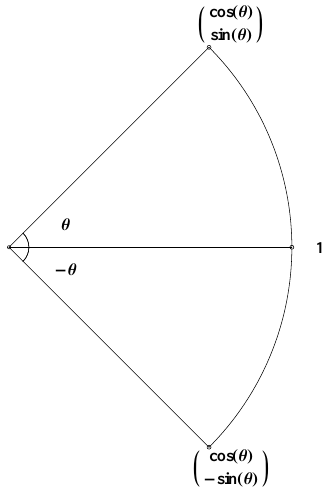
Fig. 1. A circular arc (quarter, (cid:18) D (cid:25) 4